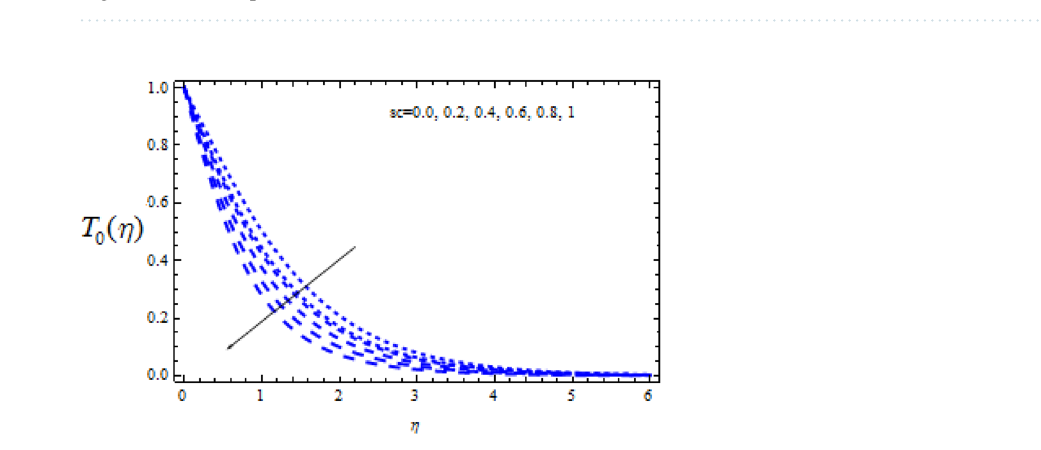
Figure 15. Consequence of M on T 1 (η) .